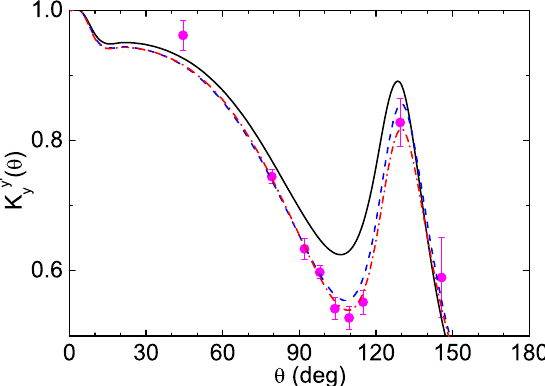
Fig. 6. Nucleon-to-nucleon polarization transfer coe ffi cient ′ = 19.0 MeV. The solid K y y ( θ ) of the pd elastic scattering at E p (black) curve denotes the calculation with AV18, the dashed (blue) curve that with AV18 + BR 680 , and the dashed-dotted (red) curve one with AV18 + BR 800 + V πσ . Experimental data are taken from Ref.